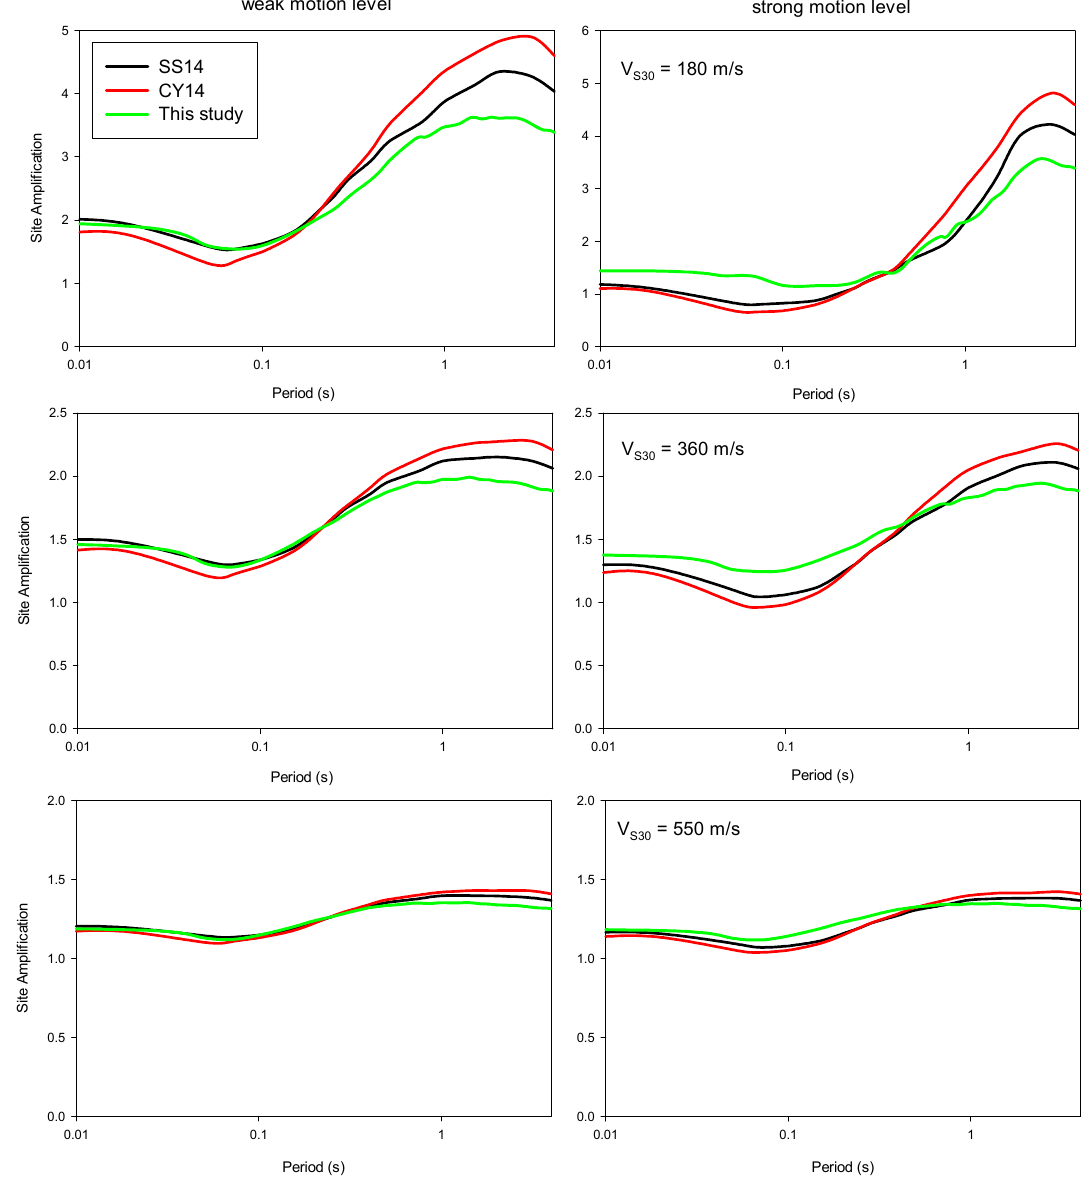
Figure 5. Period-dependent comparison of the site models for weak and strong motions in very soft soil ( V S 30 = 180 m/s), soft soil ( V S 30 = 360 m/s), and stiff soil ( V S 30 = 550 m/s). Deep soil effect is not included in the plots.